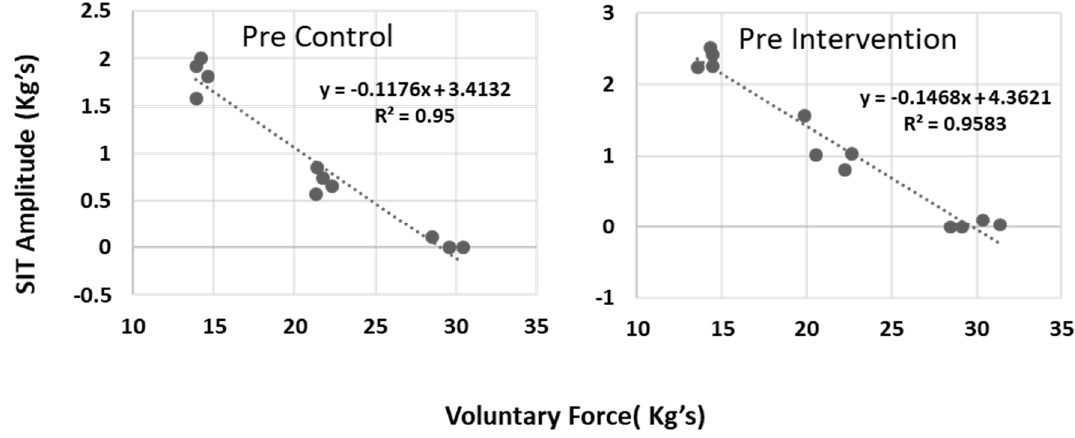
Figure 3. One representative subject’s data on two different days of linear regression analysis to calculate resting twitch.